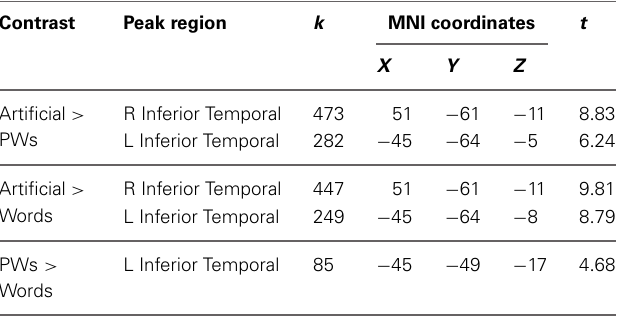
Table 2 | Visual stimuli: brain regions showing inverse word-likeness effects.